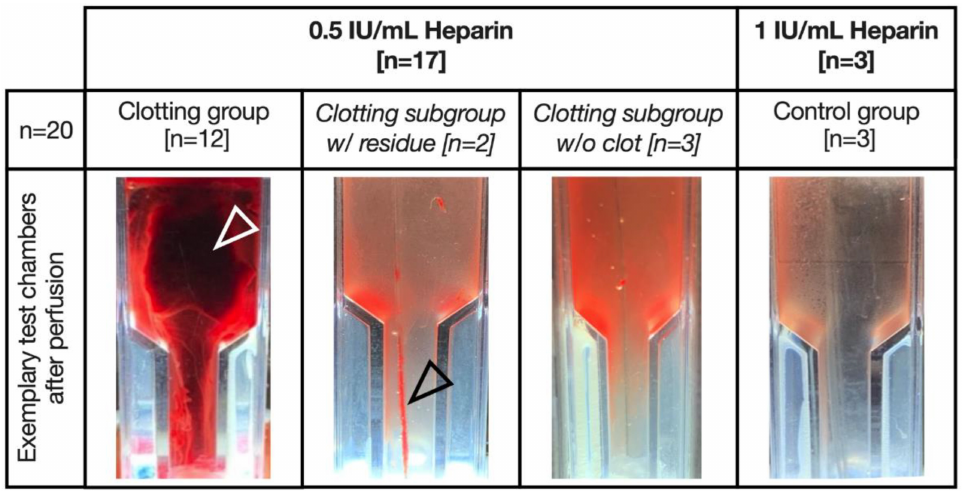
Figure 5. Exemplary images of test chambers after flushing with sodium chloride solution. White arrow: fulminant clot; black arrow: macroscopic residue on the sensor